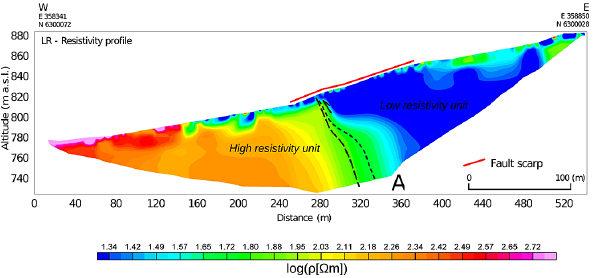
Figure 9. Inversion result along the La Reina (L2) profile, includ- ing main structures interpreted in the text. Resistivity values show a strong contrast between the eastern (conductive) and western (re- sistive) part of the